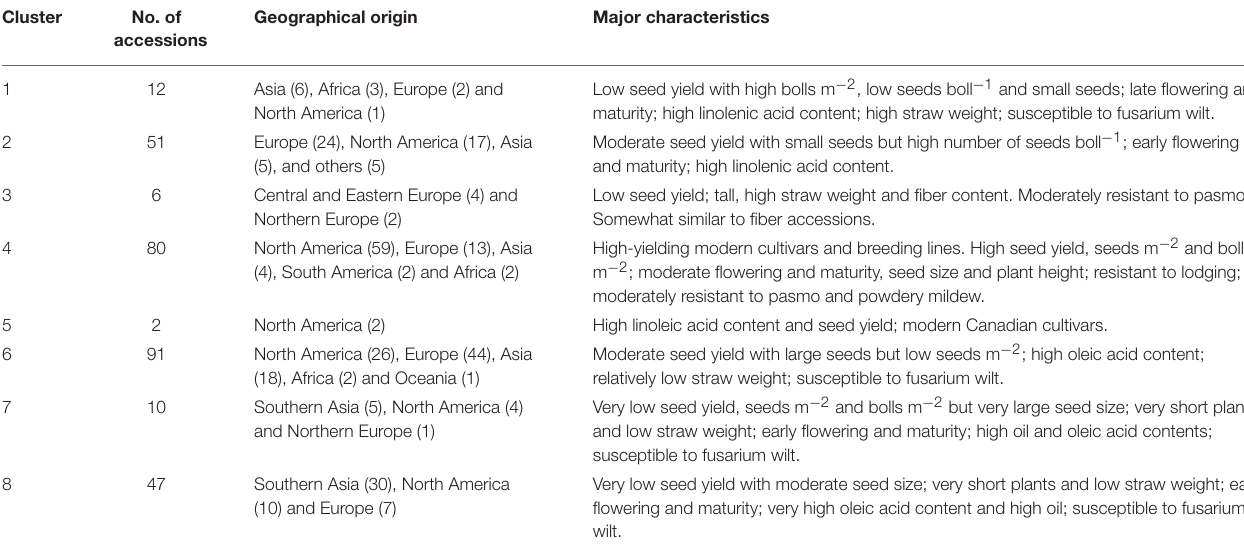
TABLE 3 | Summary of cluster analysis for 299 linseed accessions with 27 traits. Cluster No. of